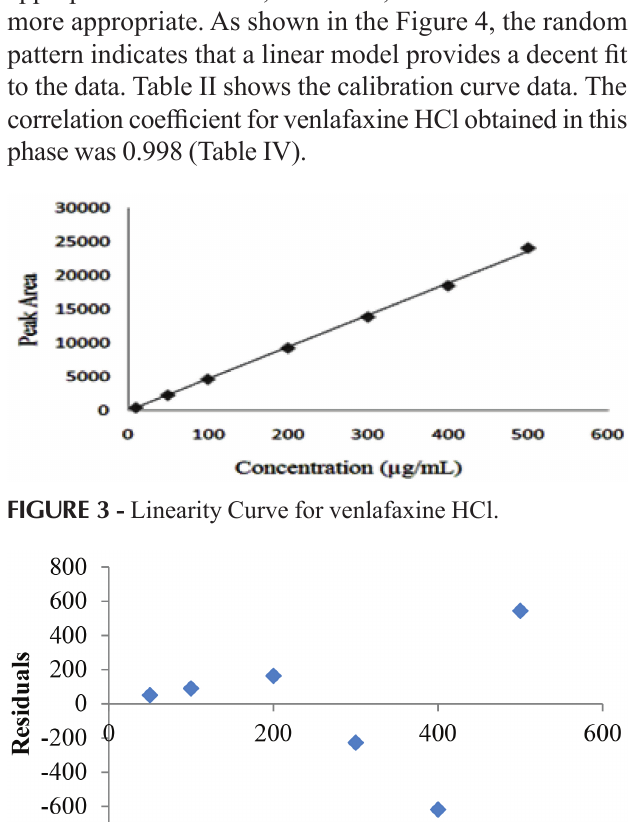
TABLE II - Linearity data for venlafaxine HCl